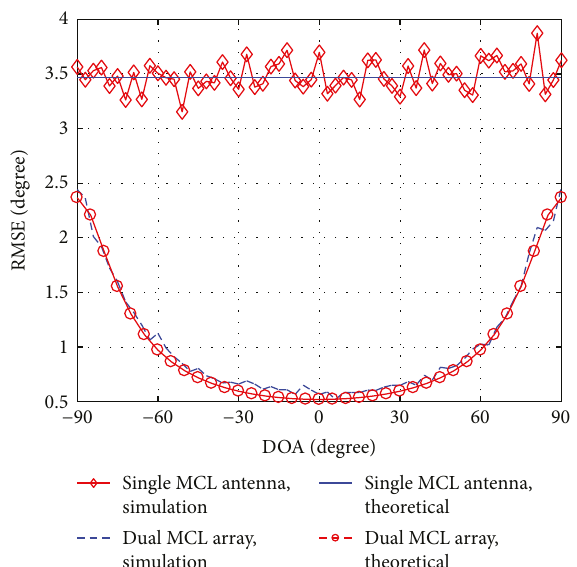
Figure 3: DOA estimation errors for the conventional single MCL antenna and the dual MCL antenna array vary with the DOA with a signal to noise ratio of 5 dB.